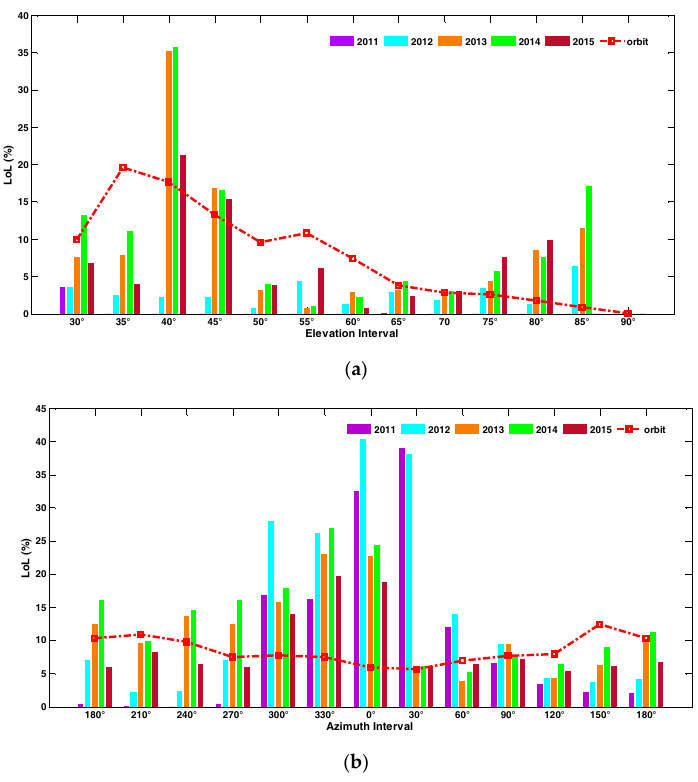
Figure 7. Loss of lock occurrence percentage towards elevation ( a ) and azimuth ( b ) from 2011 to 2015.